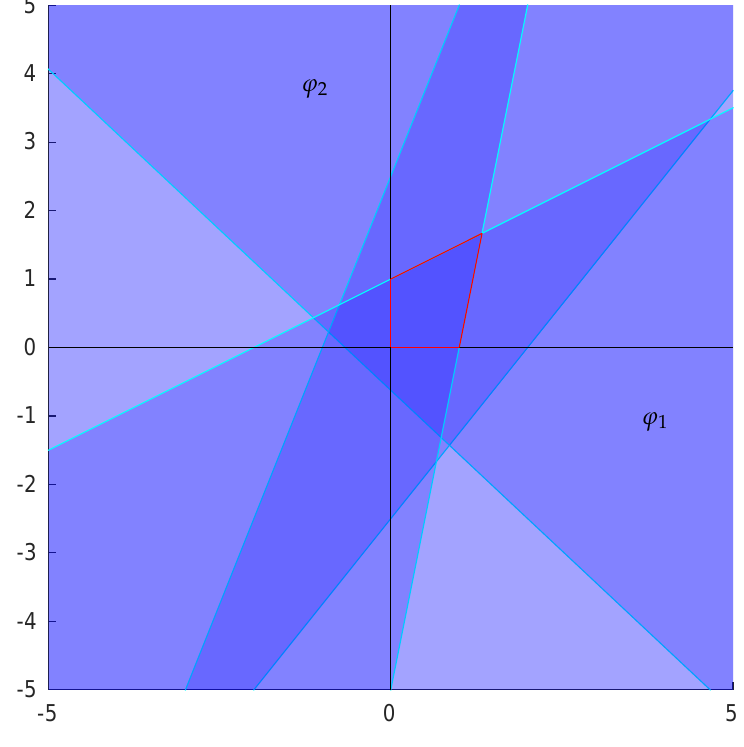
Figure 3. Solutions of the linear equations from